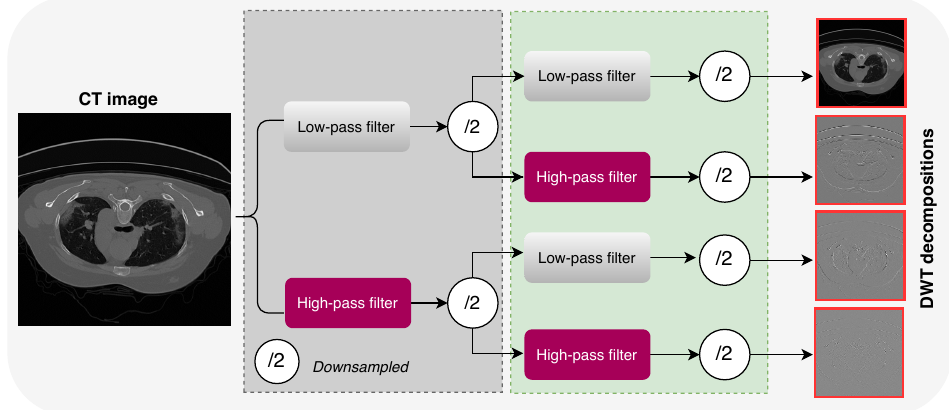
Figure 4. Illustration of decomposing a CT image into sub-band using DWT.